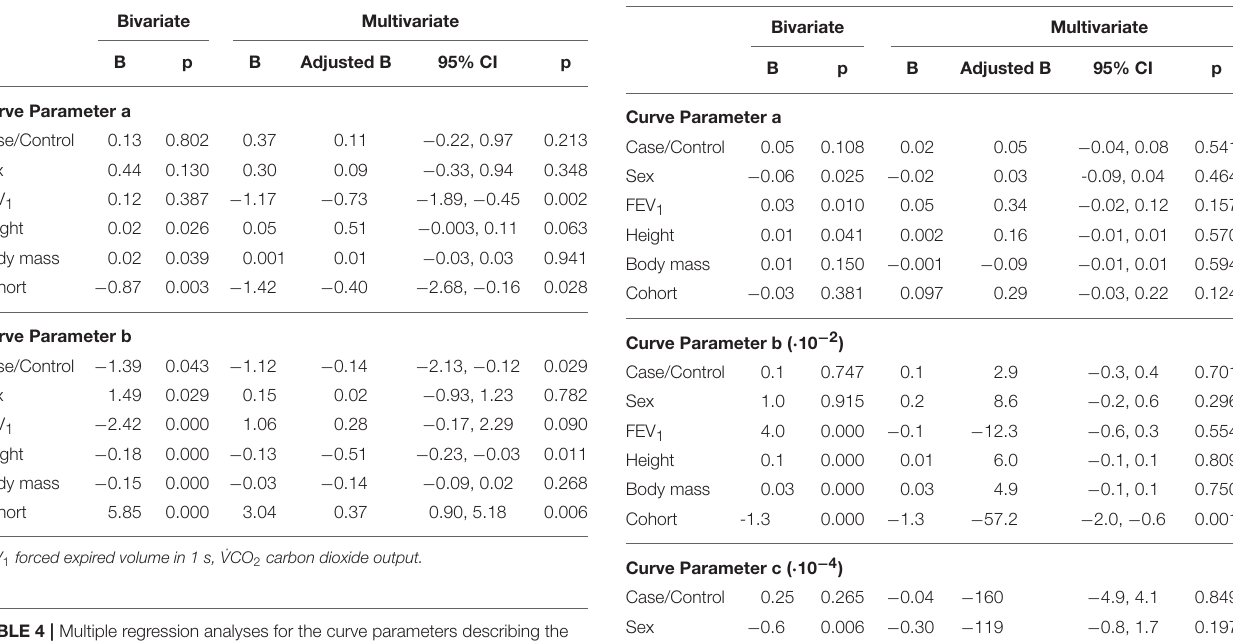
TABLE 4 | Multiple regression analyses for the curve parameters describing the relationship between HR and ˙ VO 2 , HR = a + b · ˙ VO 2 . Bivariate